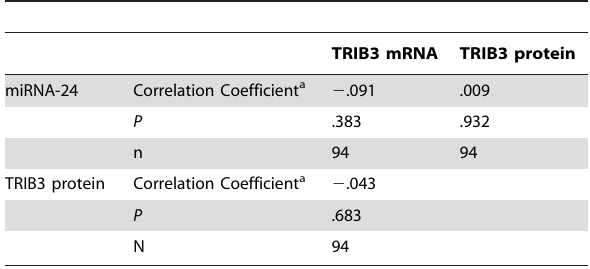
Table 1. Correlation between miRNA-24 expression and TRIB3 mRNA and protein expression.